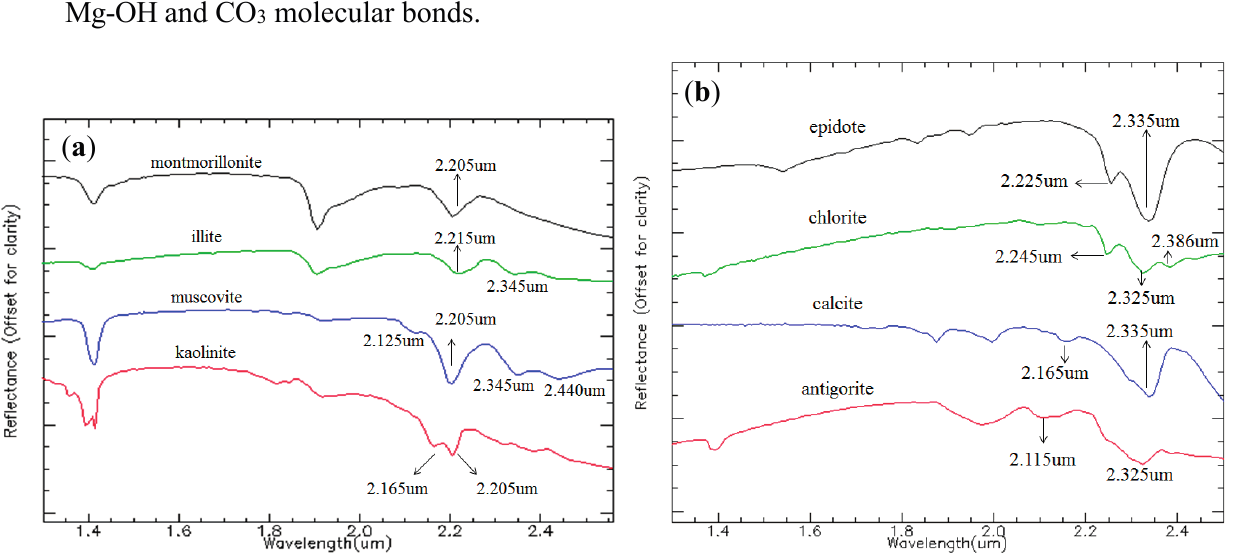
Figure 3. Detailed absorption features of samples of minerals from the USGS mineral library that are listed in Table 2. ( a ) Minerals with Al-OH molecular bonds; ( b ) Minerals with Mg-OH and CO 3 molecular